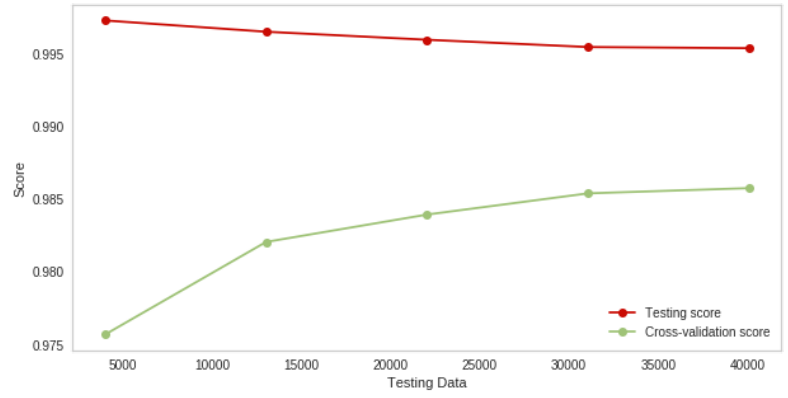
Figure 4. Random forest testing learning curve.